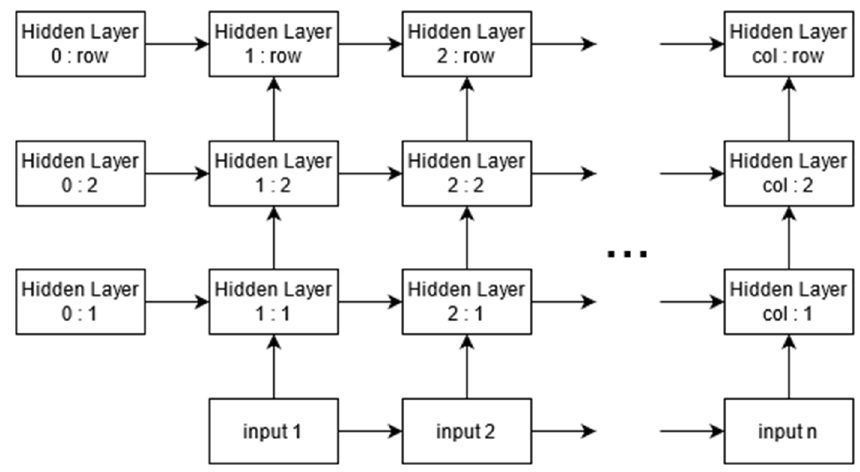
Figure 11. Proposed model for stacked RNN.